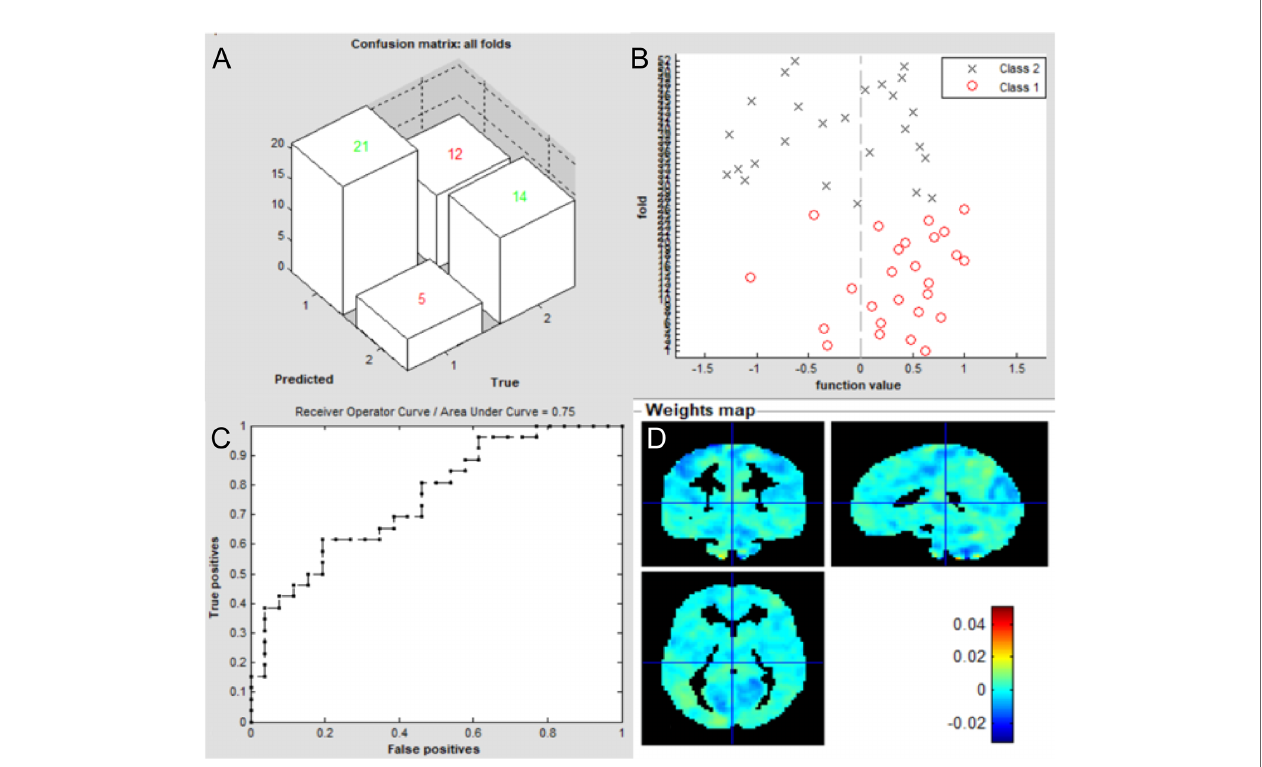
FIGURE 7 | Classi fi cation results using machine learning analysis based on FC of the right V1. (A) three-dimensional confusion matrices from machine learning analysis; (B) function values of two groups (class 1: patient group; class 2: HC group); (C) The ROC curve of the classi fi er, and the AUC was 0.75; (D) Weight maps for SVM models. The weight in each voxel corresponding to its contribution to the model ’ s prediction.